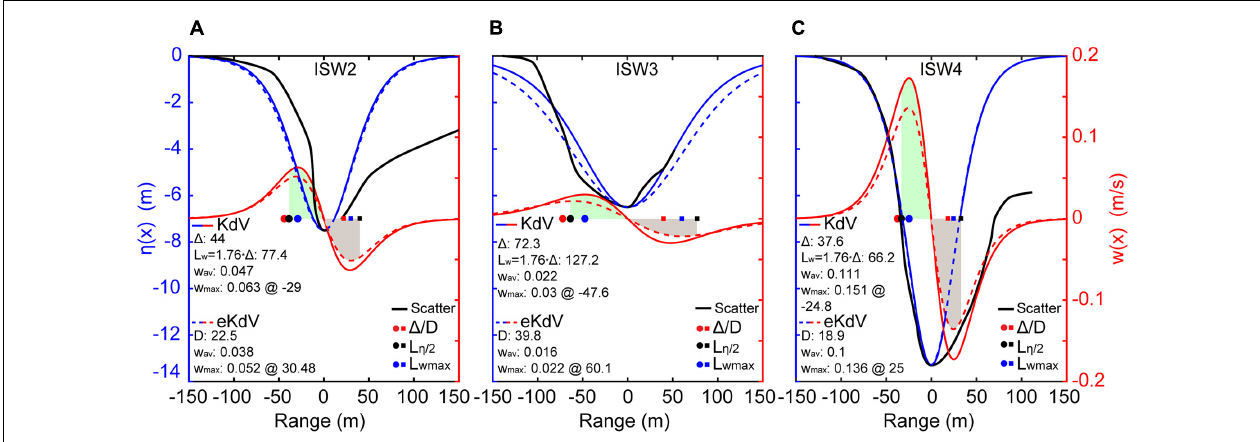
FIGURE 9 | Double-axis plots of the predicted waveforms (blue) and vertical velocities (red) using the two-layer KdV (solid curves) and eKdV (dashed curves) model for ISW2 (A) , ISW3 (B) , and ISW4 (C) . Three solid dots and squares are the characteristic width (cid:49) /D (red), half-width L η / 2 = L/2 (black), and maximum vertical velocity point L wmax (blue). The filled shades are for integrating the mean vertical velocity of the two-layer KdV (green) and eKdV (gray) model between the half-width point and the trough. Black lines are the waveforms derived from backscatter data. (cid:49) /D, characteristic width; L w , half-wave width; W av , mean vertical velocity; W max , maximum vertical